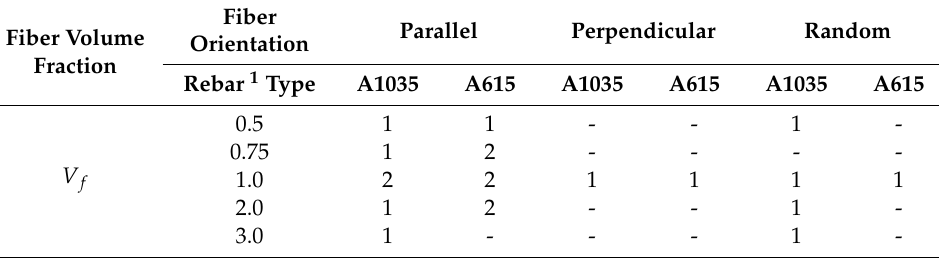
Table 3. Test Table 3. Test matrix.